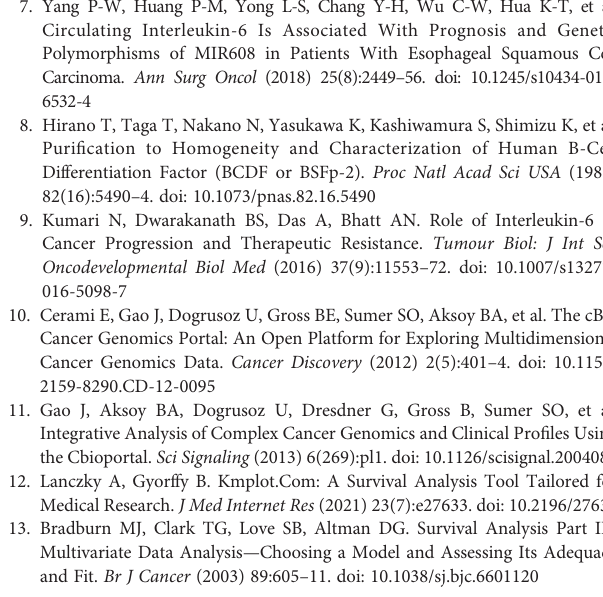
Supplementary Figure 1 | IL6 and BCL3 expression association with tumor staging and impact on overall survival. Dot plots representing IL6 and BCL3 expression relative to GAPDH according to T (A) , N (B) and M (C) from TNM staging